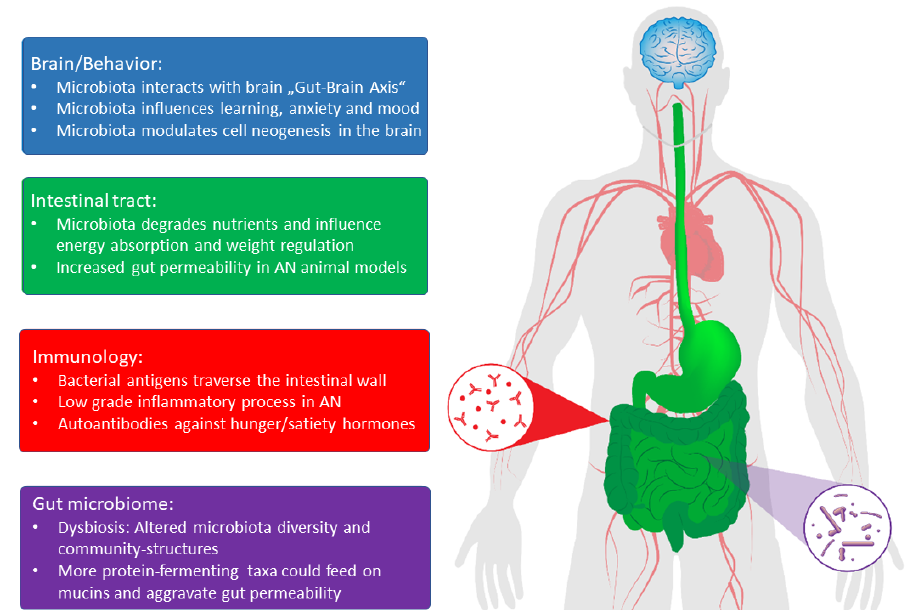
Figure 1. Effects of gut microbial products on brain functions and behavior in the intestinal tract and on immunological processes in patients with AN. (Adapted from [30]).